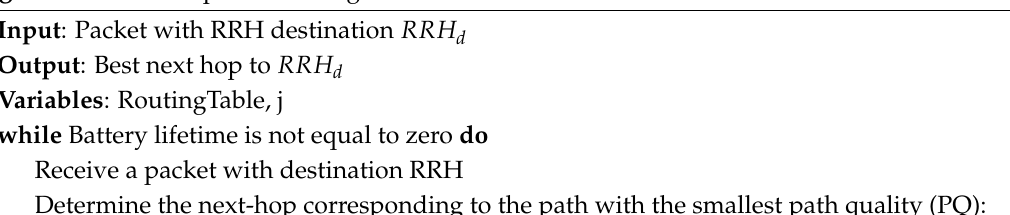
Algorithm 2 Next hop selection algorithm at D2D device